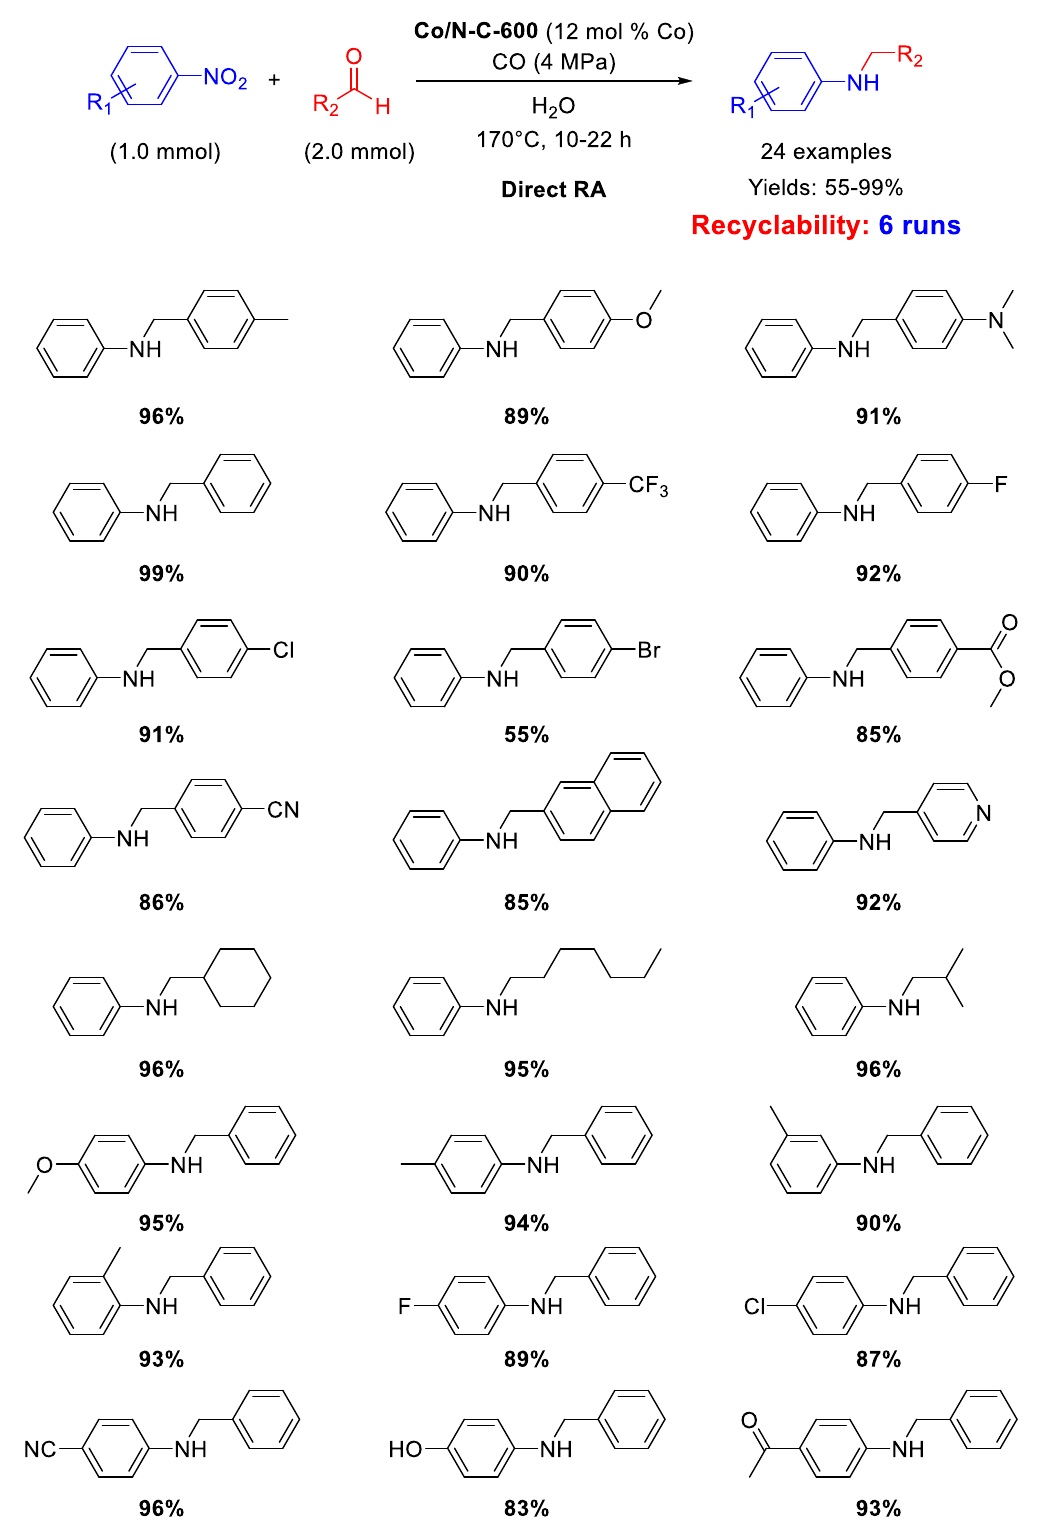
Scheme 46. DRA catalyzed by Co/N-C-600 with CO/H 2 O.